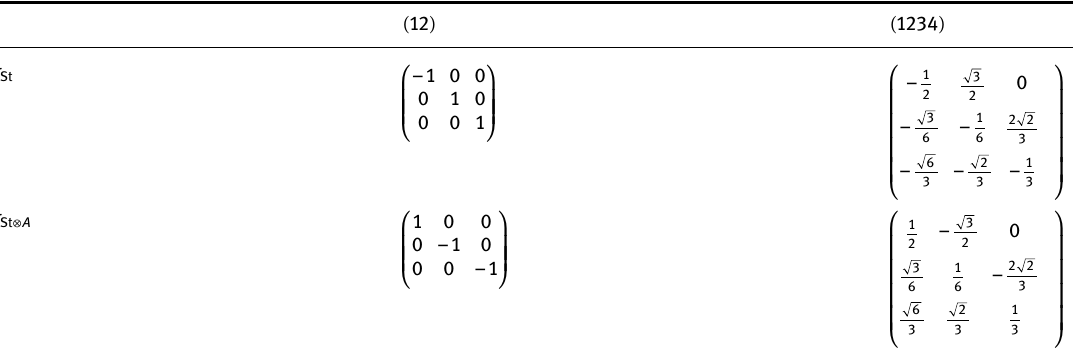
Table 1: The images of 12 ( ) and 1234 ( ) via the representations π St and π A St ⊗